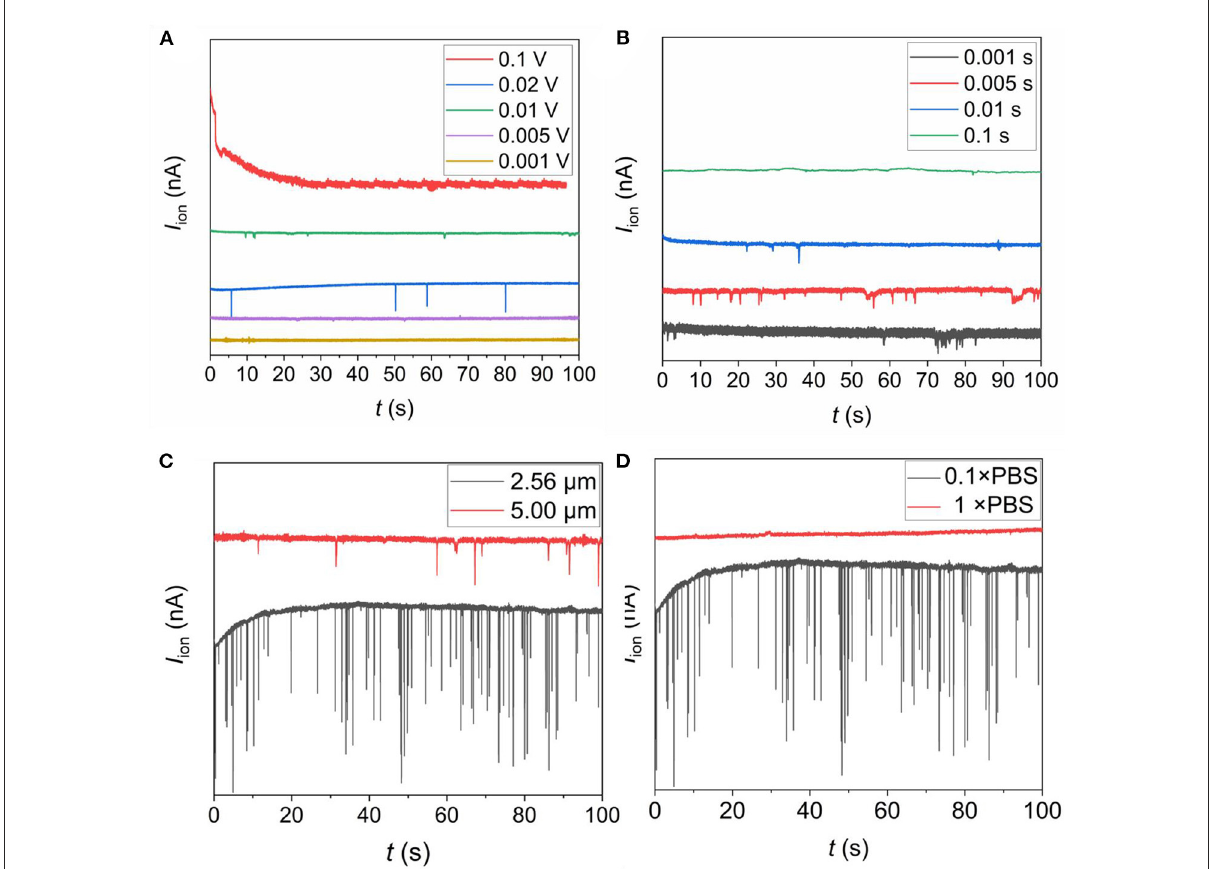
FIGURE5 Optimization of SiN chip sensing system. (A) The I ion traces of Salmonella passing through a 2.56 µ m pore at different voltages with a sampling interval of 0.005s in 0.1 × PBS buffer; (B) the I ion traces of Salmonella passing through a 2.56 µ m pore at a voltage of 0.01V with different sampling intervals in 0.1 × PBS buffer; (C) the I ion traces of Salmonella passing through a 2.56 µ m and 5.00 µ m pore at a voltage of 0.02V with a sampling interval of 0.005s in 0.1 × PBS buffer; (D) the I ion traces of Salmonella passing through a 2.56 µ m pore at a voltage of 0.02V with a sampling interval of 0.005s in 0.1 × PBS buffer and 1 × PBS